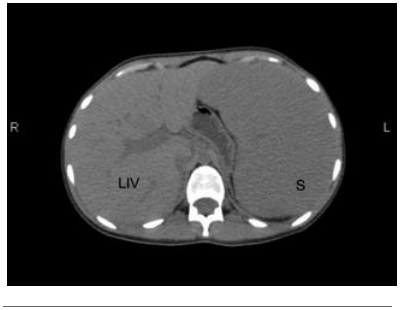
Figure 1. Computer tomography of the patient's abdomen, transverse scan. L, left; R, right; S, very enlarged spleen; LIV, enlarged liver